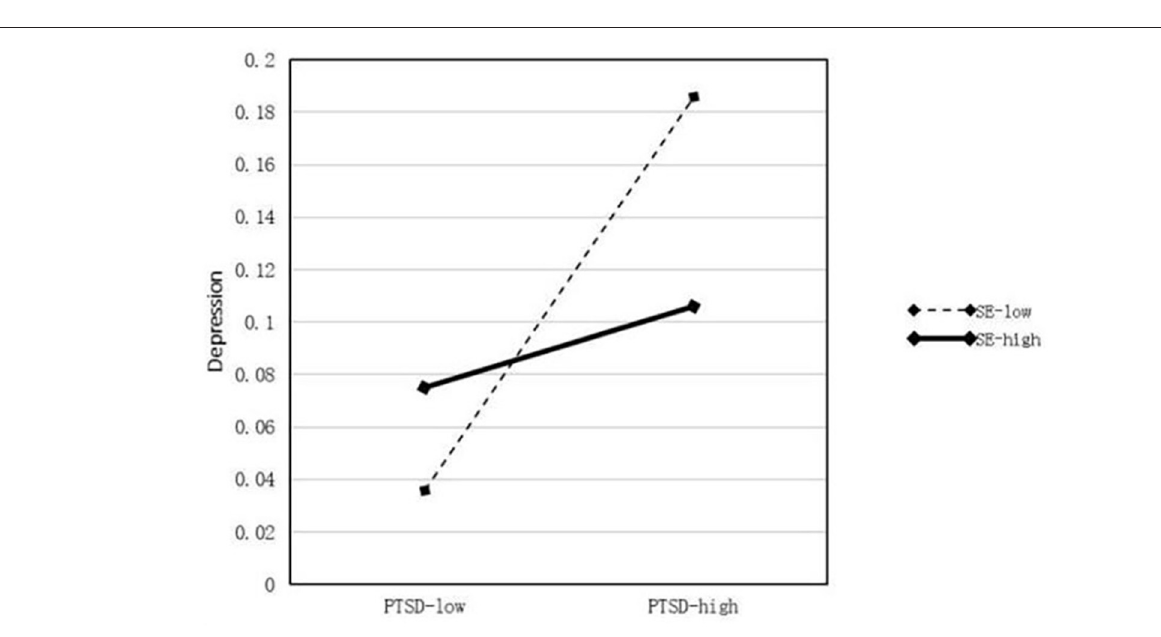
FIGURE 3 | Moderating role of self-efficacy in the effect of PTSD on